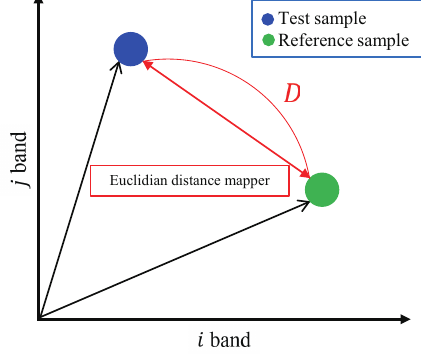
Figure 7. Description of the EDM in two bands.